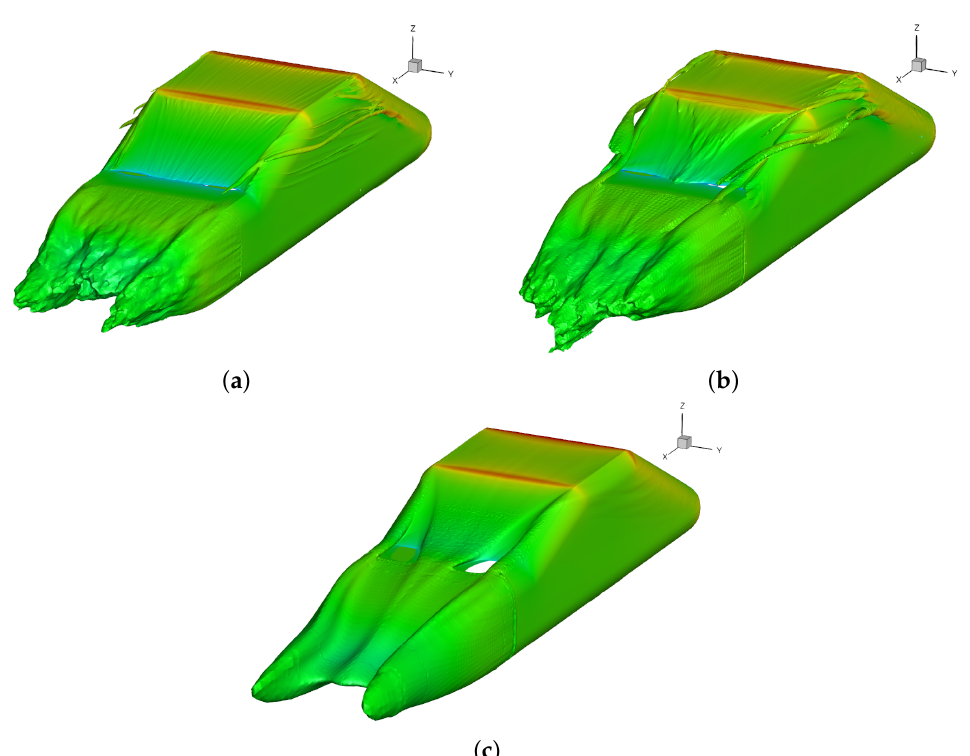
Figure 10. Iso-surfaces of the total pressure coefficient representing the rear wake profile. ( a ) HCP5,